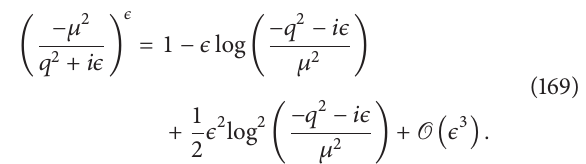
they interfere destructively. The radiative corrections are